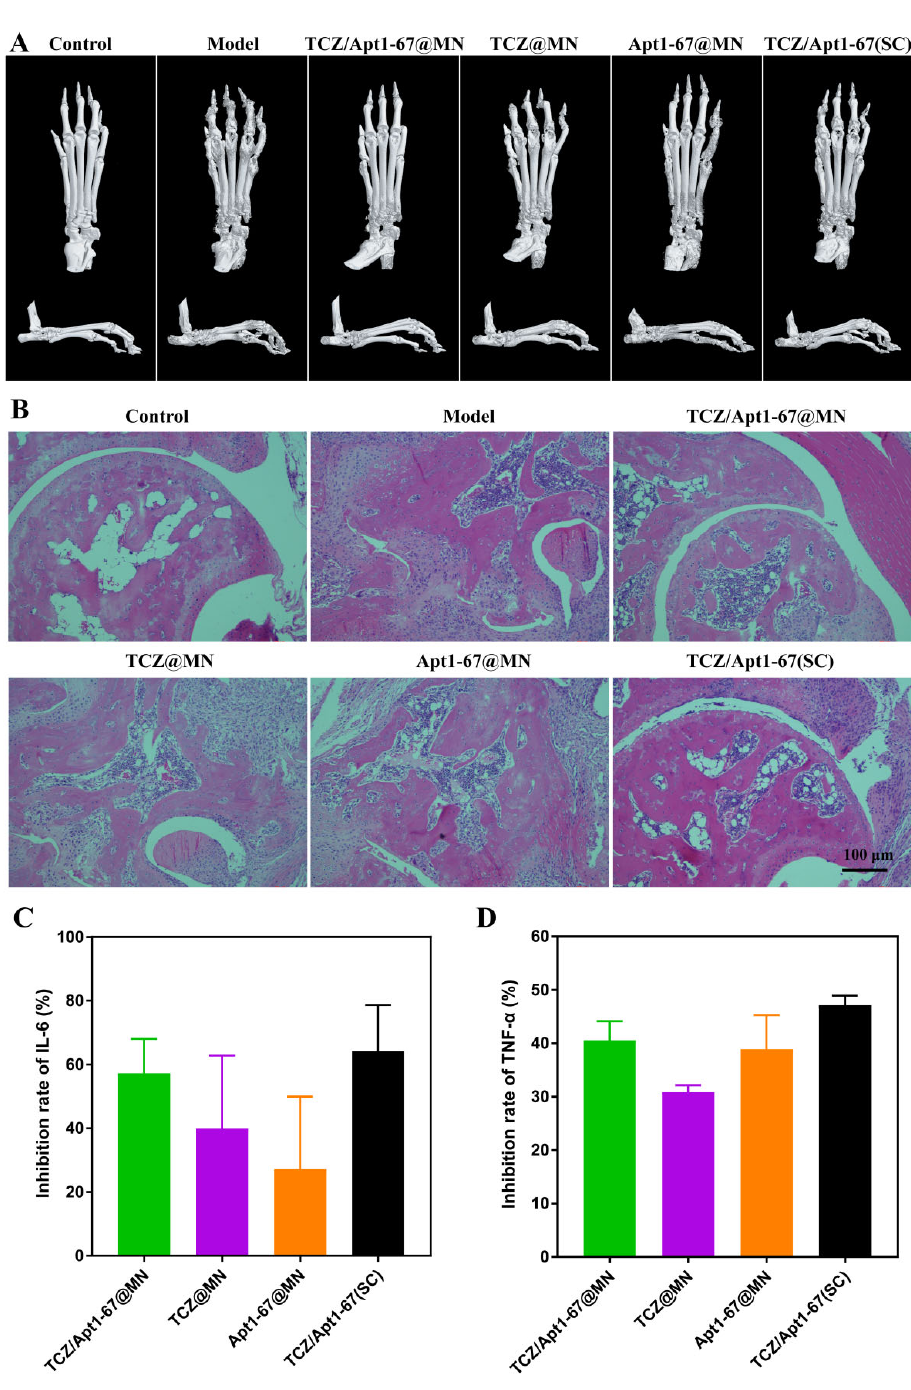
Figure 6. The effects on bone structures and cytokines. ( A ) Micro ‐ CT of ankle joints. ( B ) H & E staining of the ankle joints. ( C ) Inhibition of IL ‐ 6 and ( D ) TNF ‐α by the various